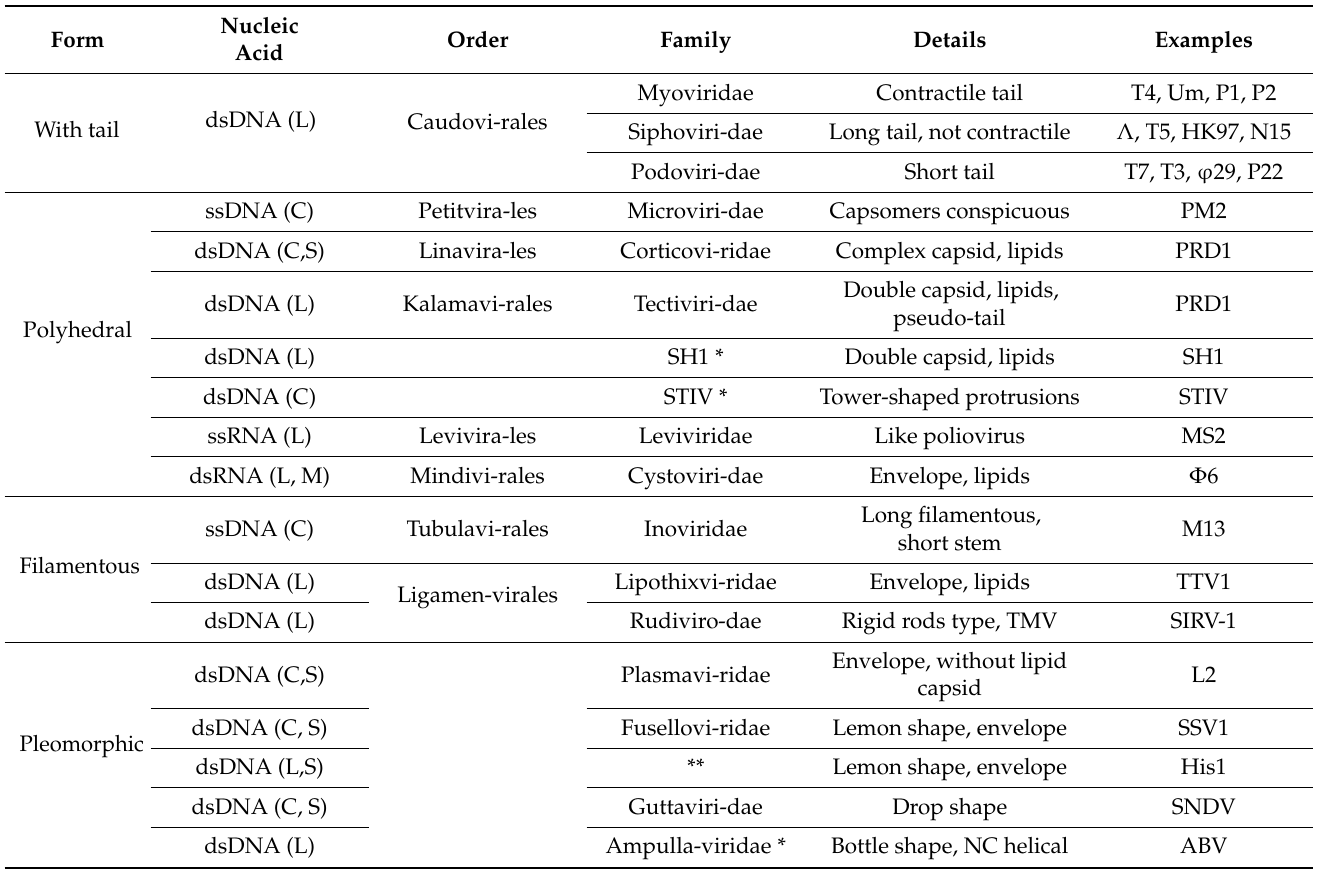
Table 1. Phage classification according to ICTV